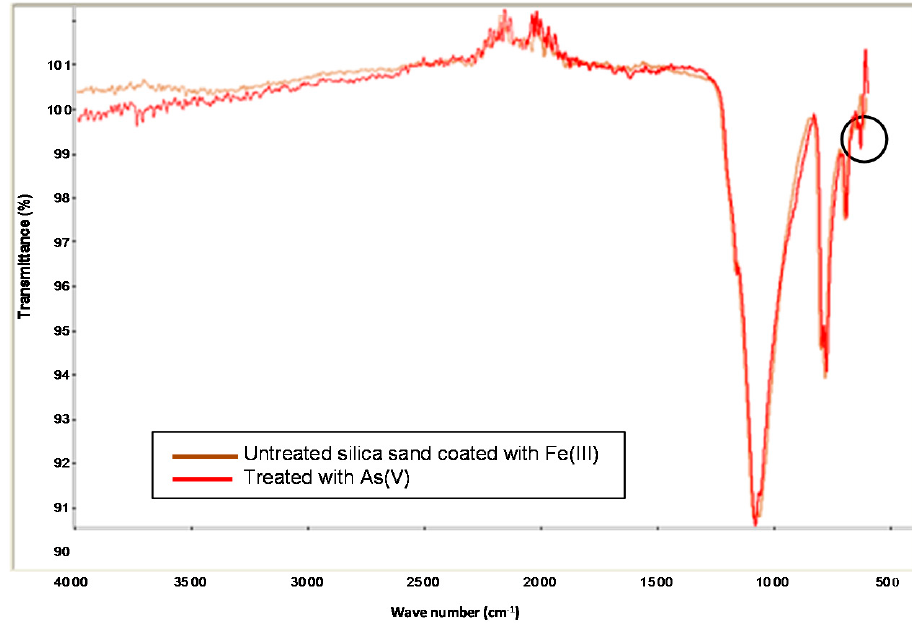
Figure 3. FTIR spectrum of silica sand coated with Fe(III) in absence and presence of As(V).